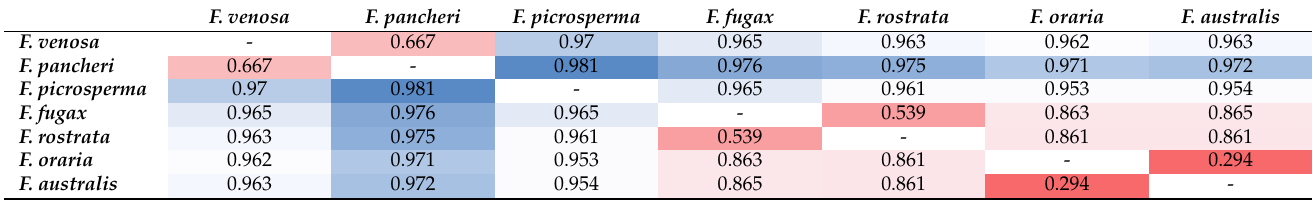
Table 2. Pairwise F ST matrix of the Austral ‐ Pacific Fontainea complex from reduced ‐ representation SNP data (5608 loci). Coloured boxes represent gradient level of genetic differentiation among each species. Gradient scale is indicated below table.